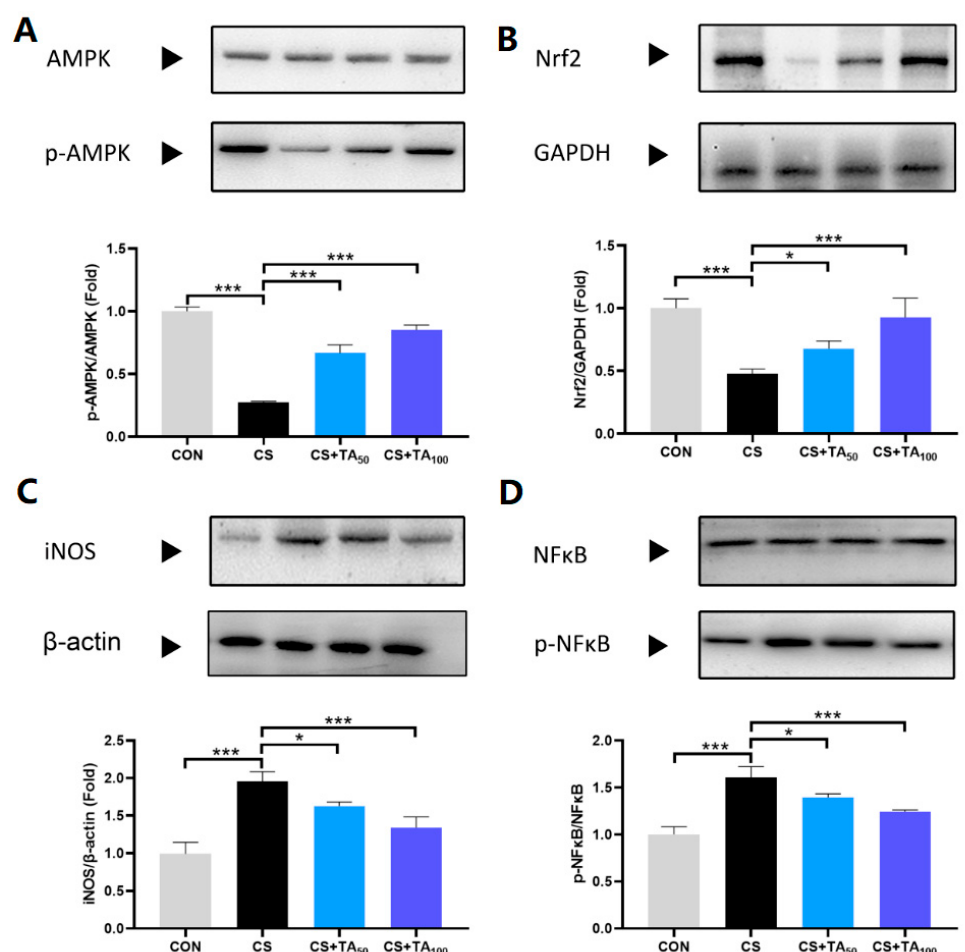
Figure 6. Effects of TA supplementation on AMPK and NF κ B signaling pathways in the lungs of CS- exposed induced-COPD mice. Expression of ( A ) AMPK and p-AMPK, ( B ) Nrf2, ( C ) iNOS , and ( D ) NF κ B and p-NF κ B in lung tissues from each group were measured by Western blot. * P < 0.05, *** P <